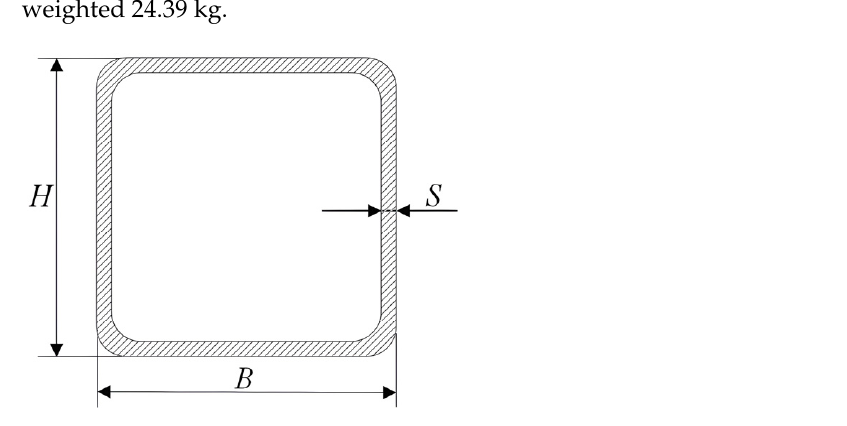
Figure 7. Cross-section of the rectangular tube: H —height; B —width; S —wall thickness. Taking into account the profile parameters, the cross section was 32.4 cm 2 . The cross- section area obtained was higher than that calculated by Formula (2). It should be noted that with these cross-section values, the profile strength would not be provided under the bending moment. Therefore, the profile was chosen by the values obtained by Formula (1). Taking into account the given profile, the module mass was about 0.88 tons. If neces- sary, the removable module structure can be supplemented with stops (walls), tying rings, brackets, or other devices for securing the freight.